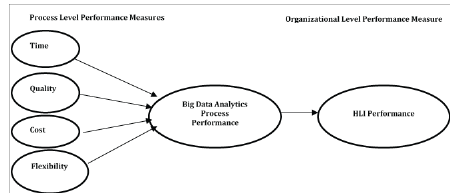
Figure 2 : Conceptual framework of BDA Process performance